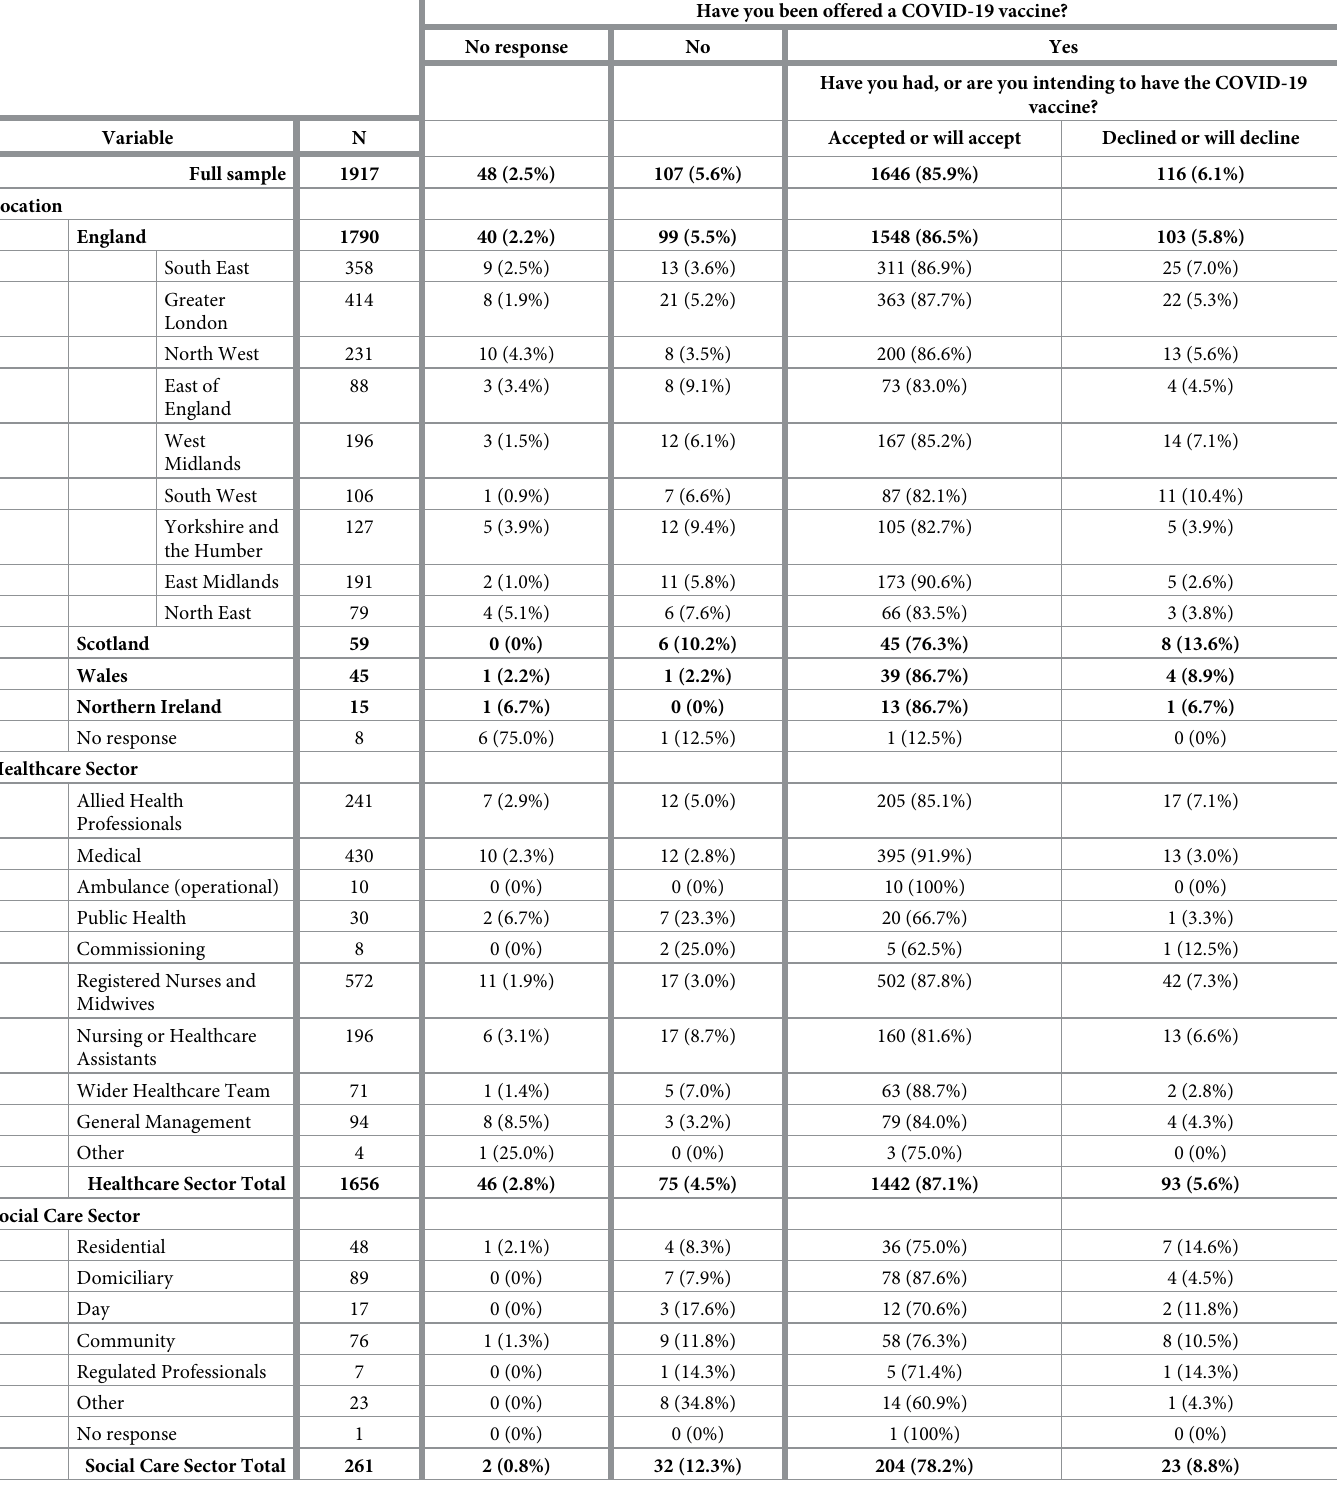
Table 3. Participants location and occupation by being offered a vaccine and vaccine